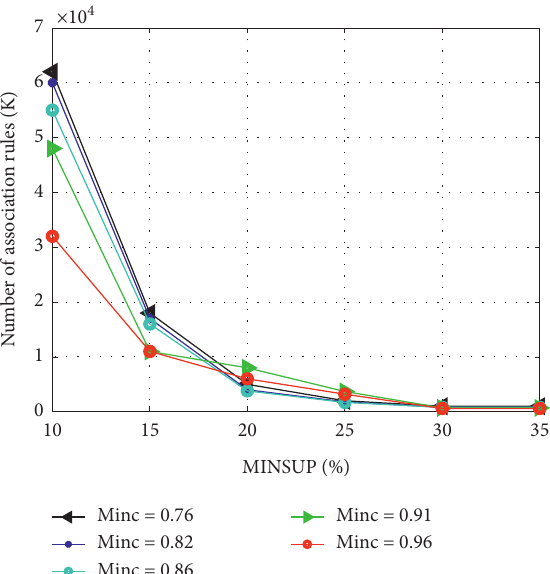
Figure 5: Number of association rules of art features with different minimum support and minimum confidence.